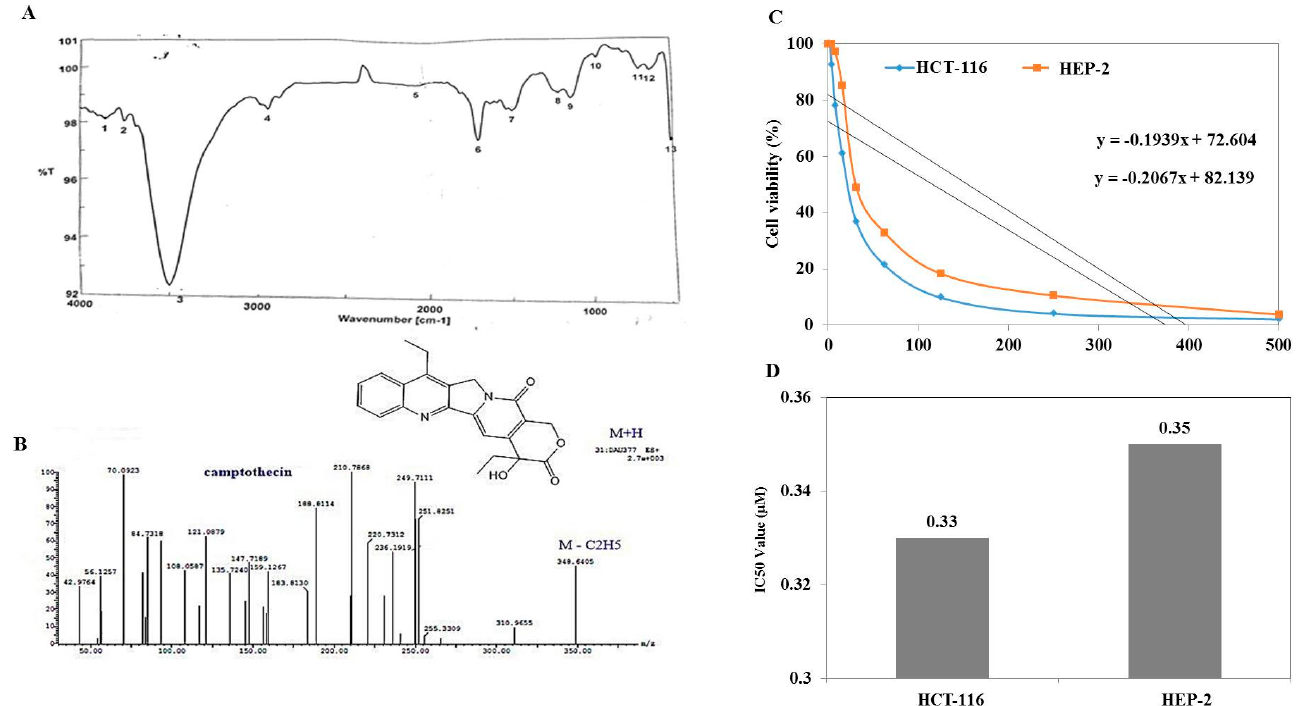
Figure 3. Chemical analysis and anticancer activity of P. chrysogenum extracted camptothecin. After growing P. chrysogenum under standard conditions, camptothecin was extracted and checked by TLC, putative spots scraped off, and camptothecin extracted and chemically analyzed. ( A ) FTIR chromatogram of extracted camptothecin. ( B ) LC-MS/MS analyses of extracted camptothecin. The antiproliferative activity of extracted camptothecin against human larynx carcinoma (HEP-2) and colon carcinoma cell lines as revealed from the viability plot ( C ) and IC 50 values ( D ).